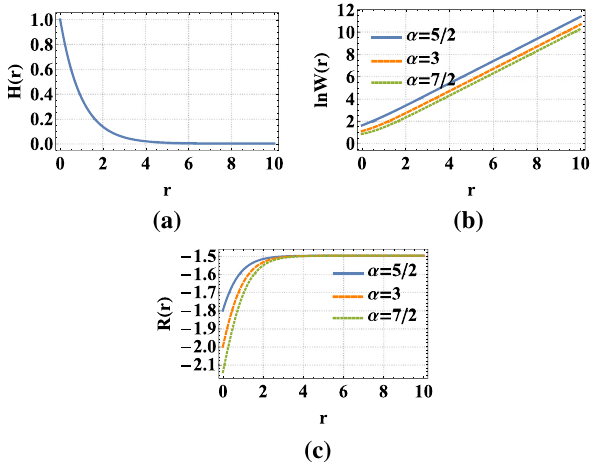
Fig. 1 Plots of the metric components (30)–(31), and the curvature scalar (40) in the limit D → 4 for the first solution. a The metric component H ( r ) . b Themetriccomponent W ( r ) . c Thecurvaturescalar R ( r ) . The parameters are set to k = 1 and C 1 = − 1 /( 1 − α/ 2 )